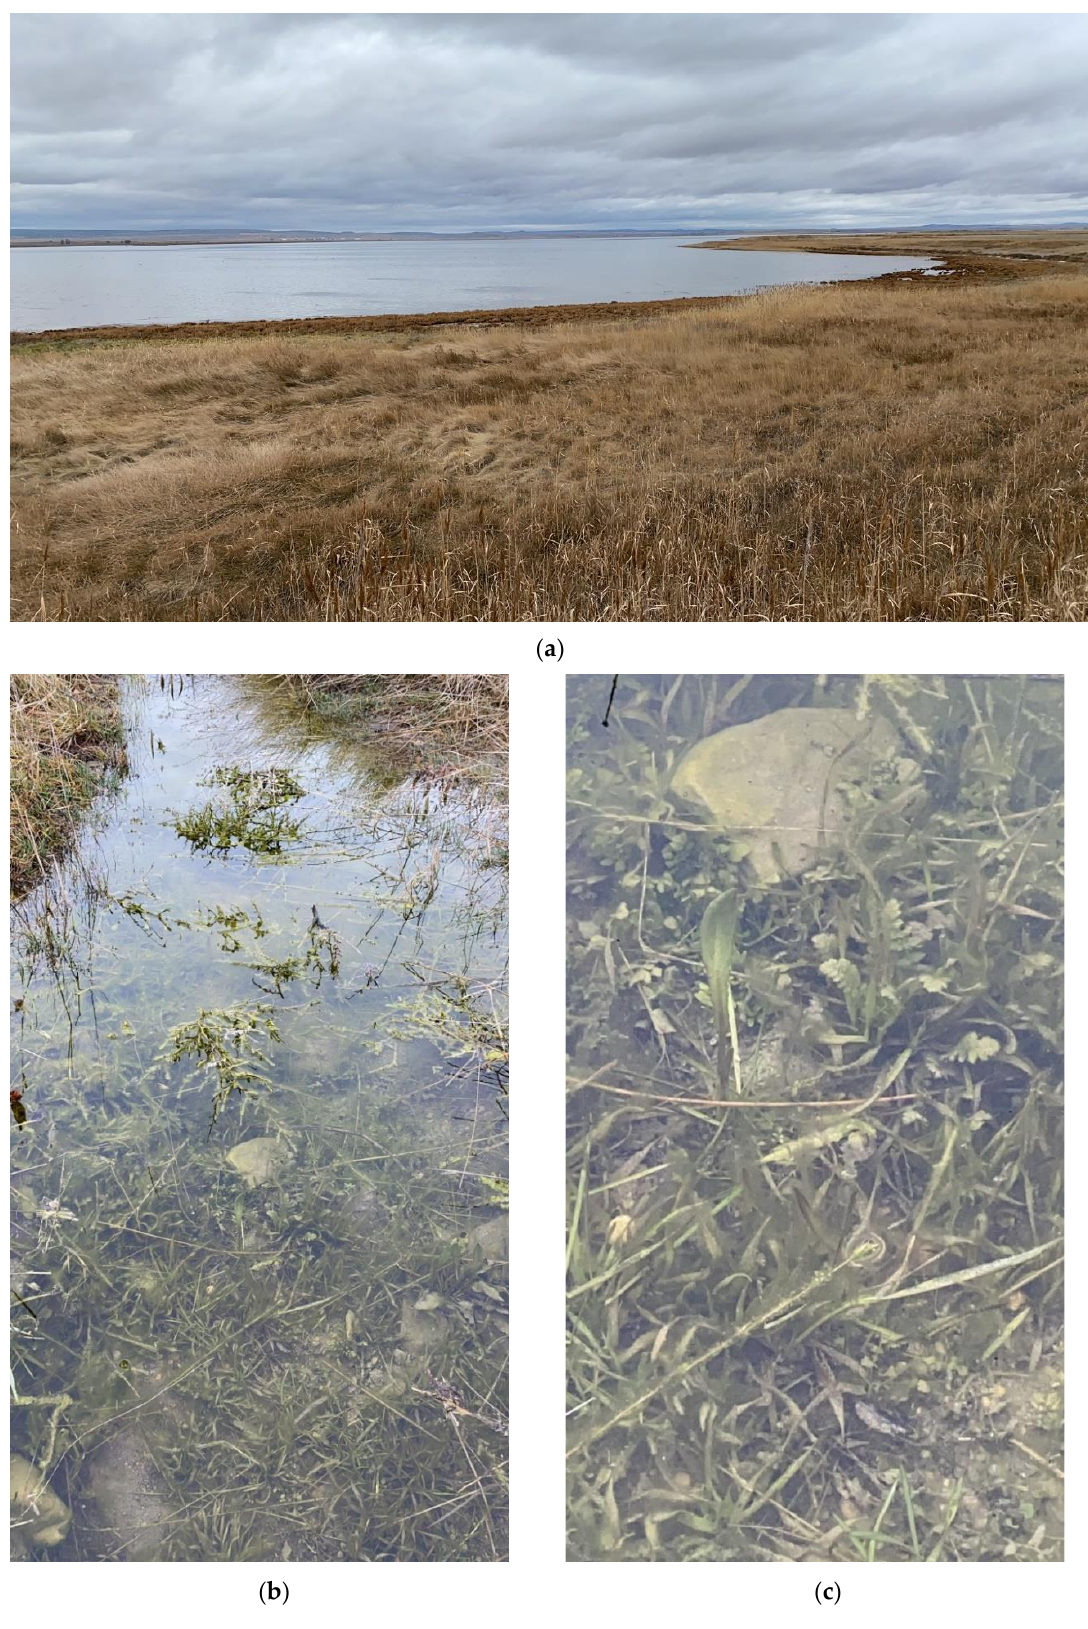
Figure A1. Pictures of vegetation in Gallocanta Lake shore: ( a ) General view from Northeast area in autumn (transect zone A–B in Figure 1). ( b , c ) Detail of submerged aquatic plants.